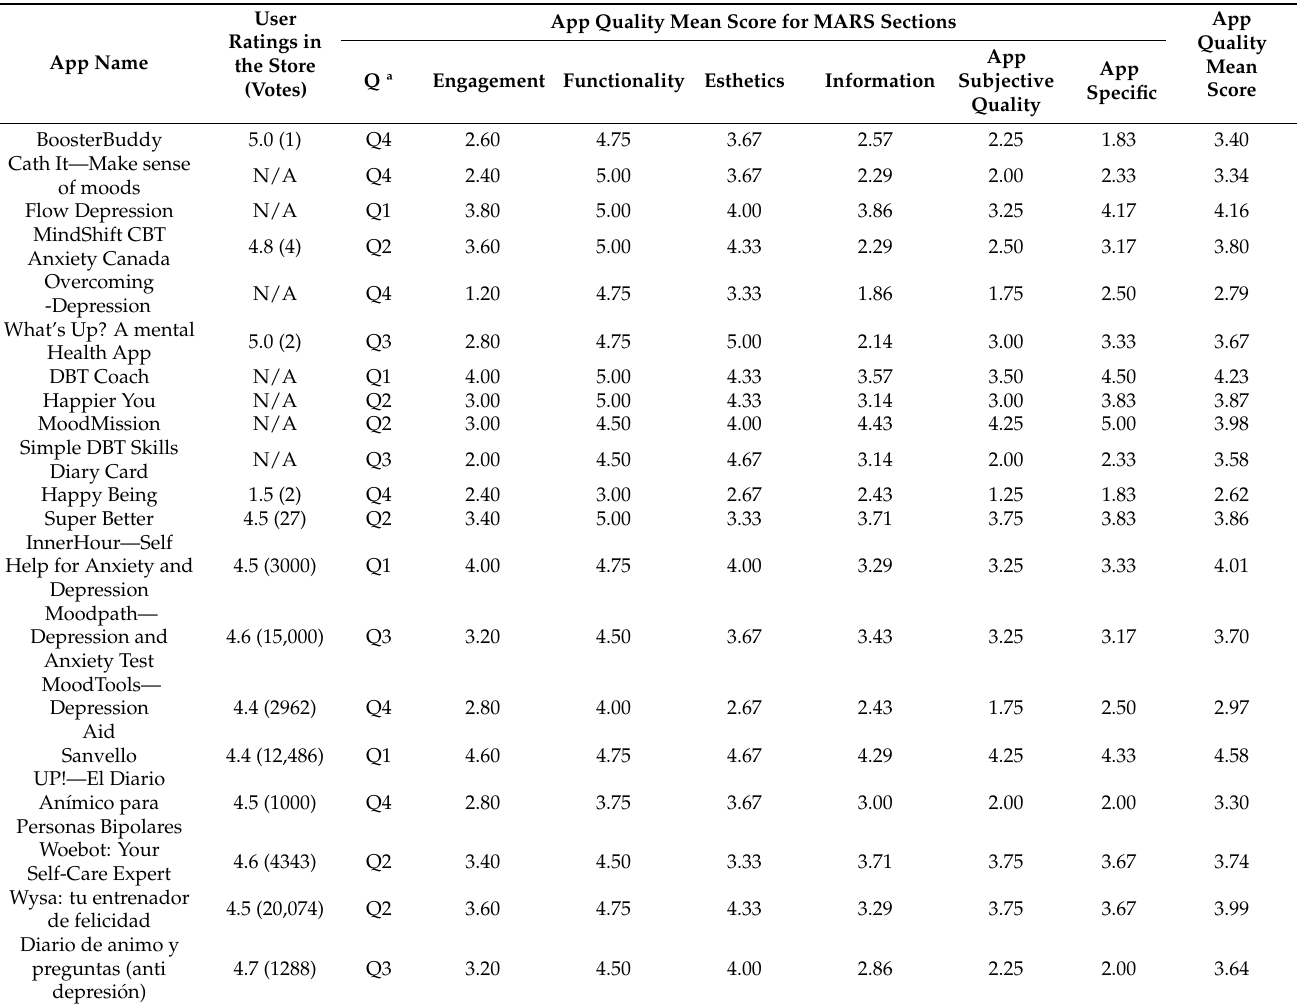
Table 3. Mobile Application Rating Scale of